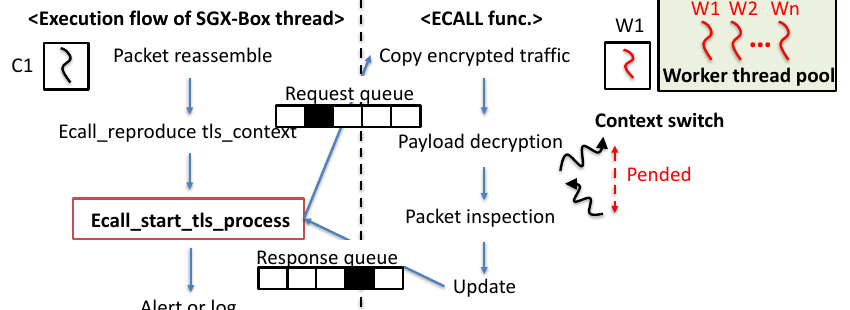
Figure 3. An example of Switchless ECALL in SGX-Box application. Context switches while executing ECALL function introduce pending of the SGX-Box caller